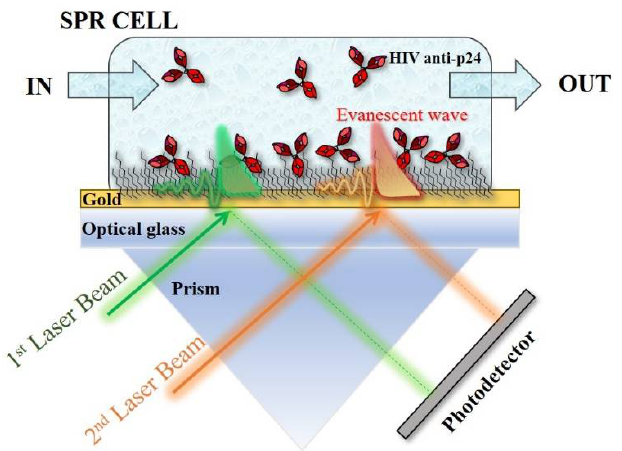
Figure 1. SPR apparatus in the Kretschmann configuration. During the biofunctionalization of gold, the green and orange laser beams ( λ = 670 nm) sampled the surface in two points and serves to monitor the layer homogeneity.